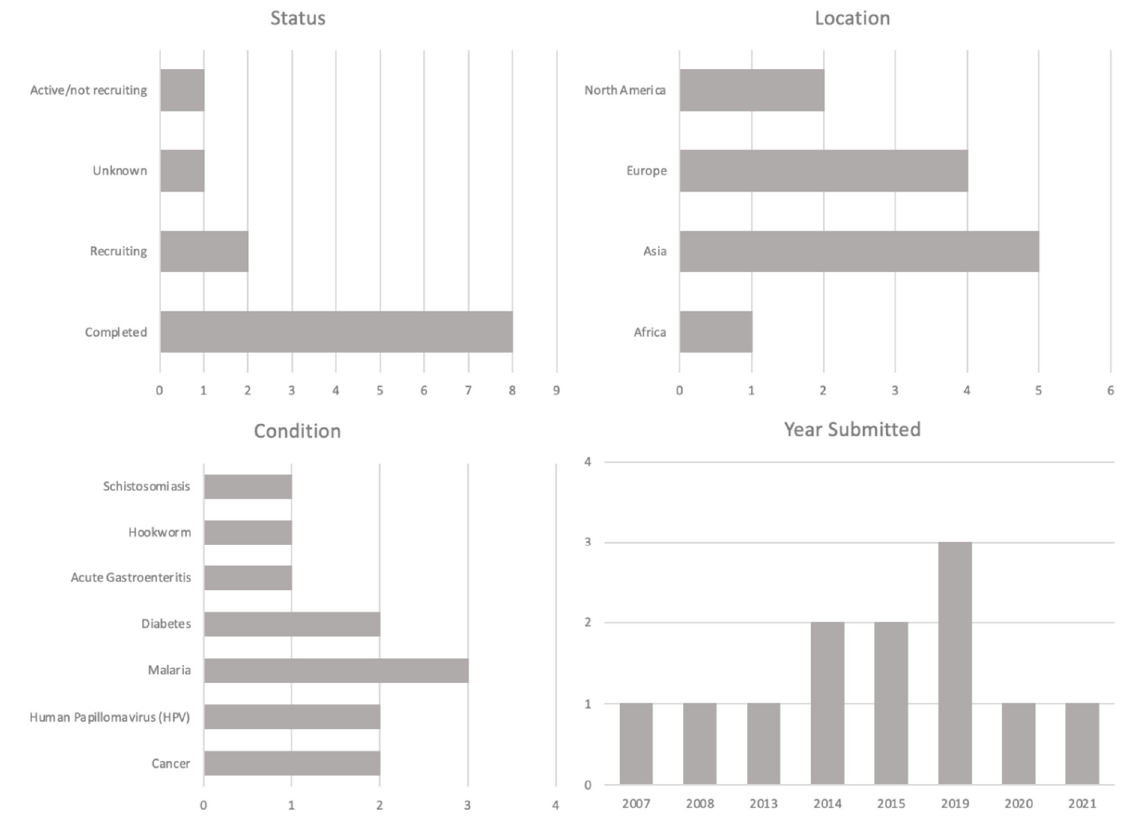
Figure 2. Clinical trials overview using P. pastoris as a production platform (clinicaltrials.gov, assessed on 5 August 2021).